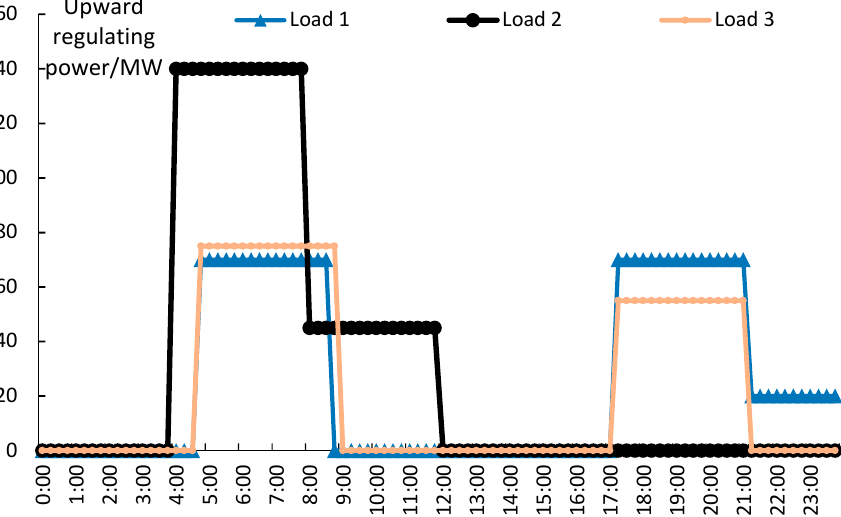
Figure A2. Regulation of energy-intensive loads in Mode 2.